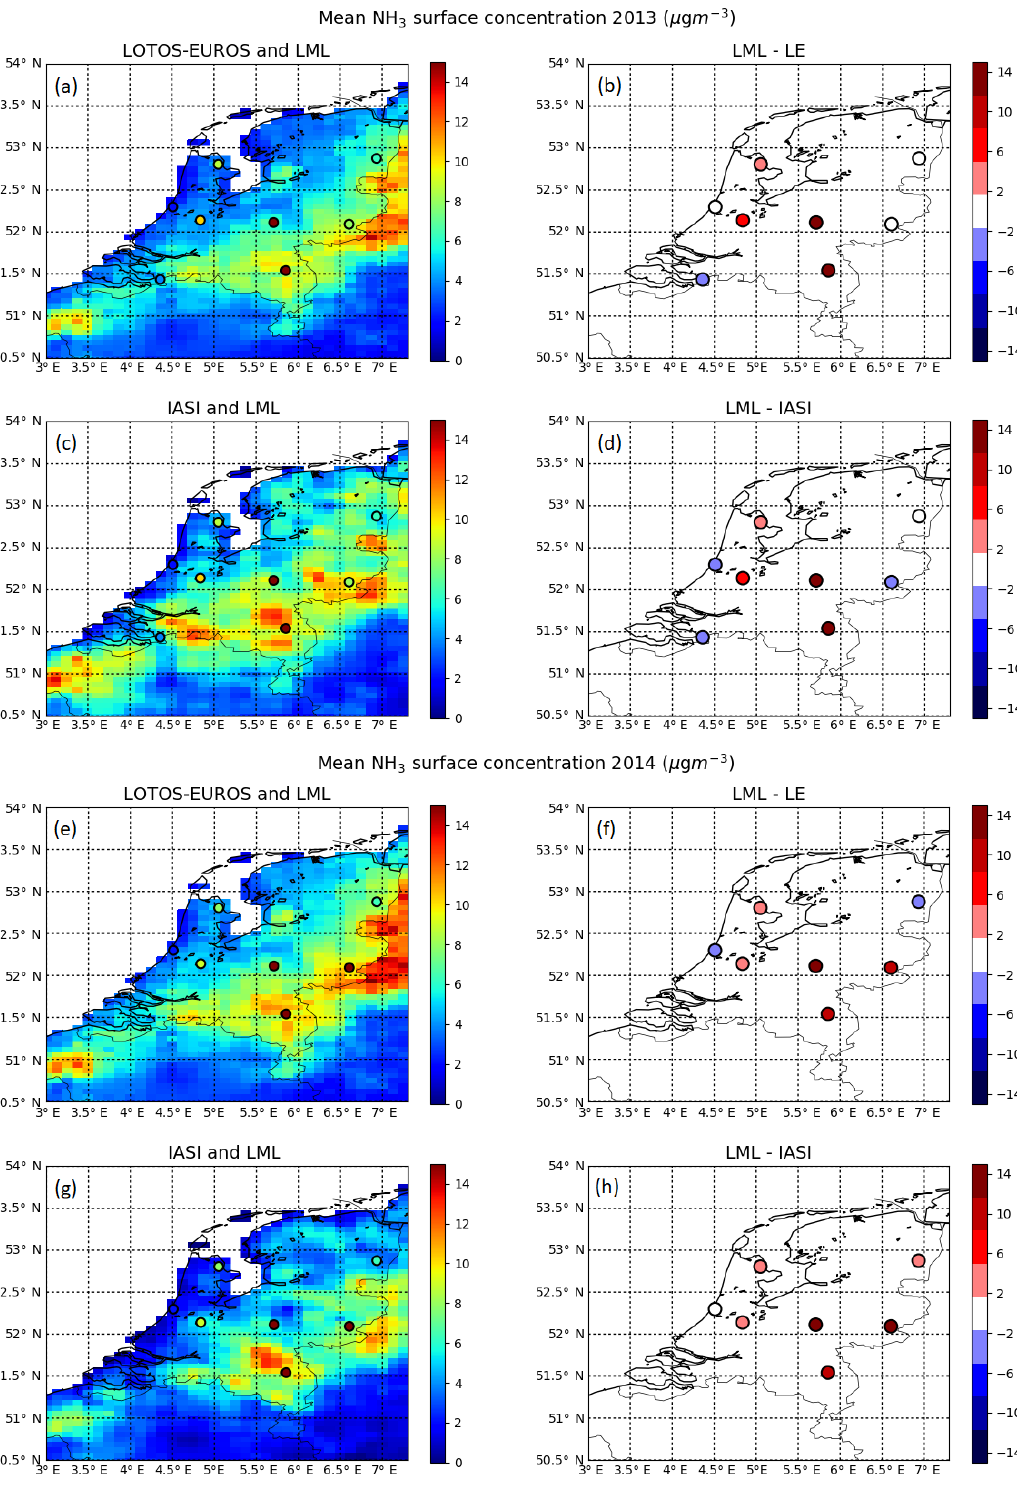
Figure 6. Comparison of the warm season (April–September) mean NH 3 surface concentration in 2013 (a, b, c, d) and in 2014 (e, f, g, h) from LOTOS-EUROS and derived using IASI. The corresponding warm season mean NH 3 surface concentrations measured by the LML stations are plotted on top of the left figures. The right figures depict the differences between the